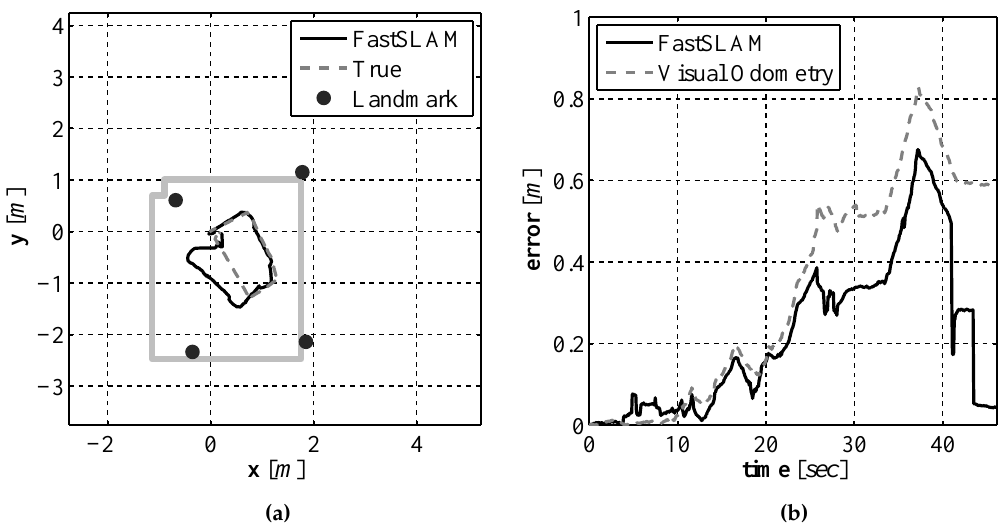
Figure 25. The FastSLAM produced path and map estimate ( a ) and the error in the position estimate over time ( b